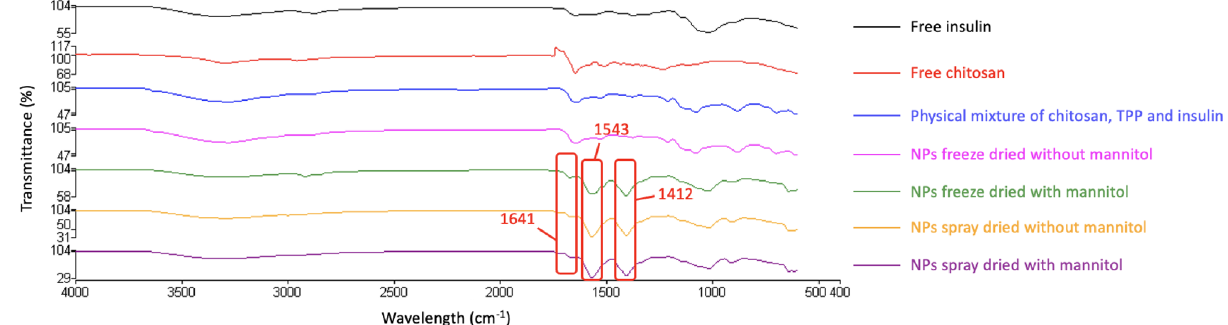
Figure 3. FTIR-ATR spectra of free insulin, chitosan, physical mixture of chitosan/TPP/insulin and NPs dehydrated by different methods.